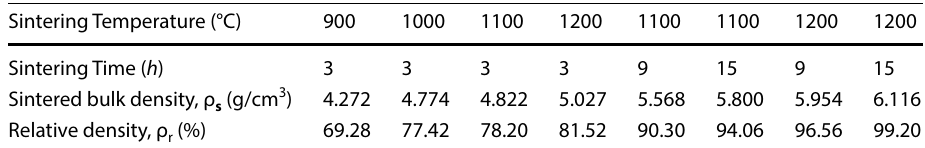
Sintering Temperature (°C) Sintering Time ( h )